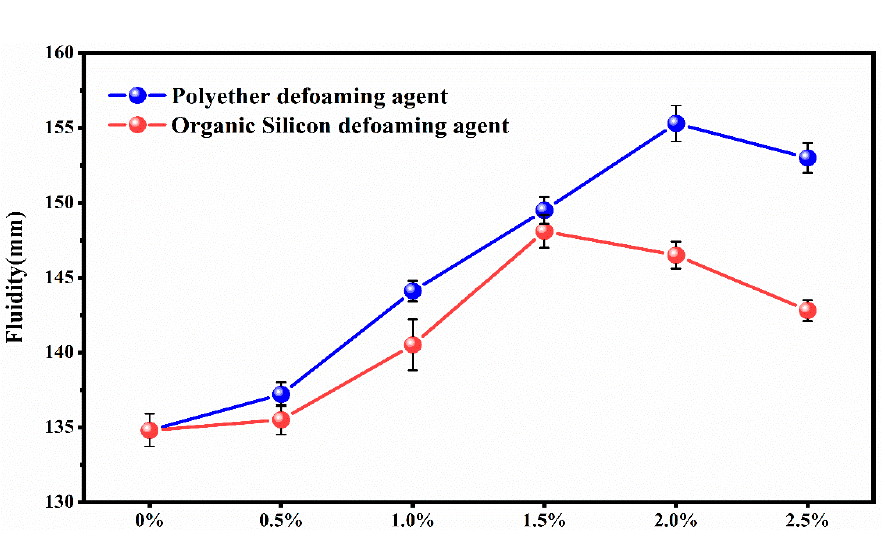
Figure 9. Density. Figure 10. Water absorption.